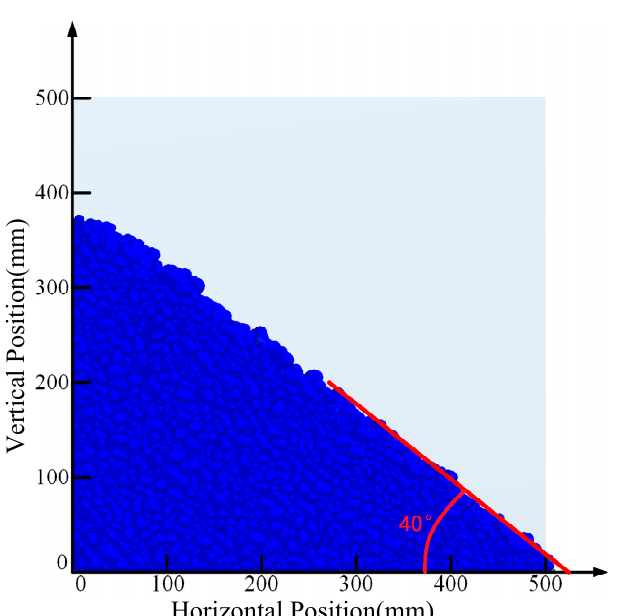
Figure 8. Measurement of the natural accumulation angle.